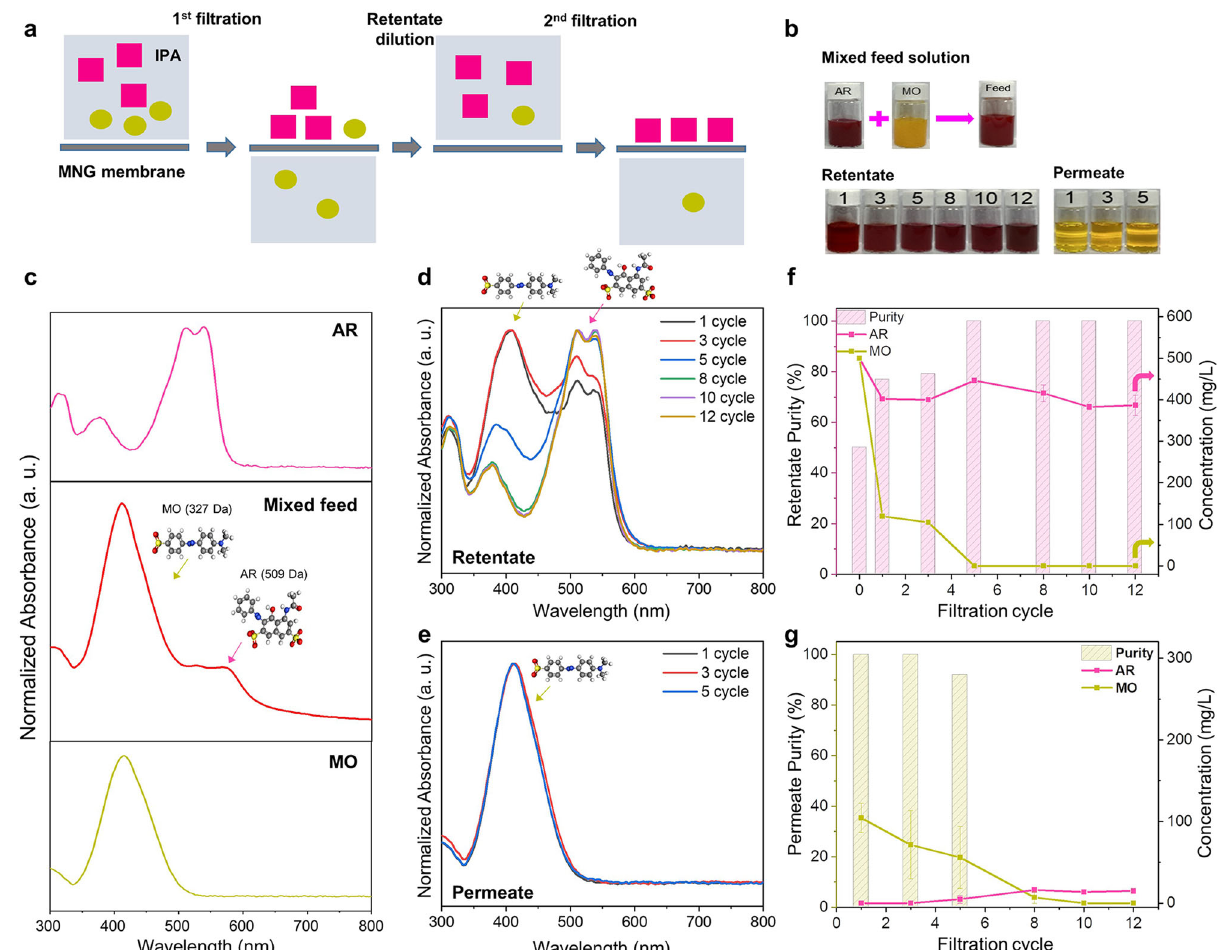
Fig. 6 | MNG membrane for binary dye mixture separation under dead-end fi ltration. Thetestwasconductedat3baranddilutionwasconductedwith100mL of IPA. The total concentration was 1000 ppm in IPA and the weight ratio of the dyeswas1:1. a Schematicillustrationofbinarydyemixtureseparation.Thecolored squareandcirclearedyemolecules. b Photographsoffeed,re-dispersedretentate,